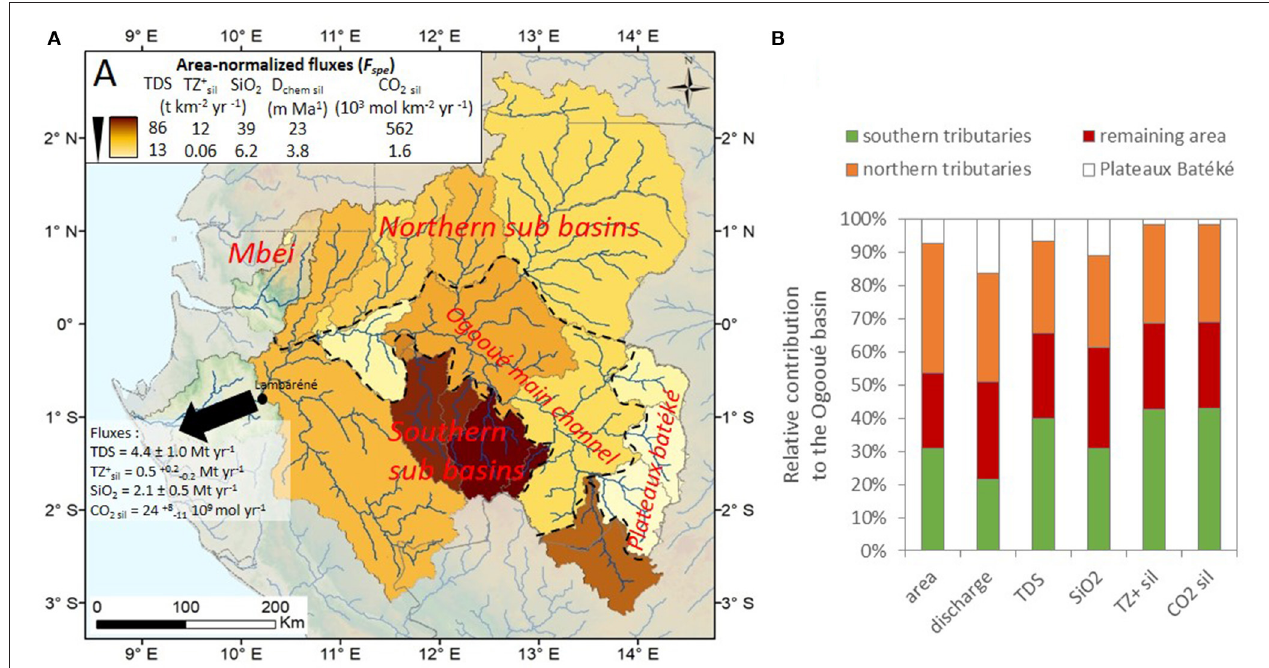
FIGURE 9 | Spatial distribution of weathering fluxes in the Ogooué Basin: (A) Color map showing the spatial distribution of specific fluxes ( F spe ) of TDS, TZ + sil , SiO 2 , and associated CO 2 sil consumption F spe distribution throughout the Ogooué Basin (the darkness of the color is proportional to these rates; the extreme values are reported in the caption). Note that at this scale the basins of the Mbei tributaries are too small to be visible. (B) Relative contribution of each region in term of drainage area, discharge and fluxes of TDS, TZ + sil , SiO 2 , and CO 2 sil consumption. The uncertainties are reported in Table 4 .